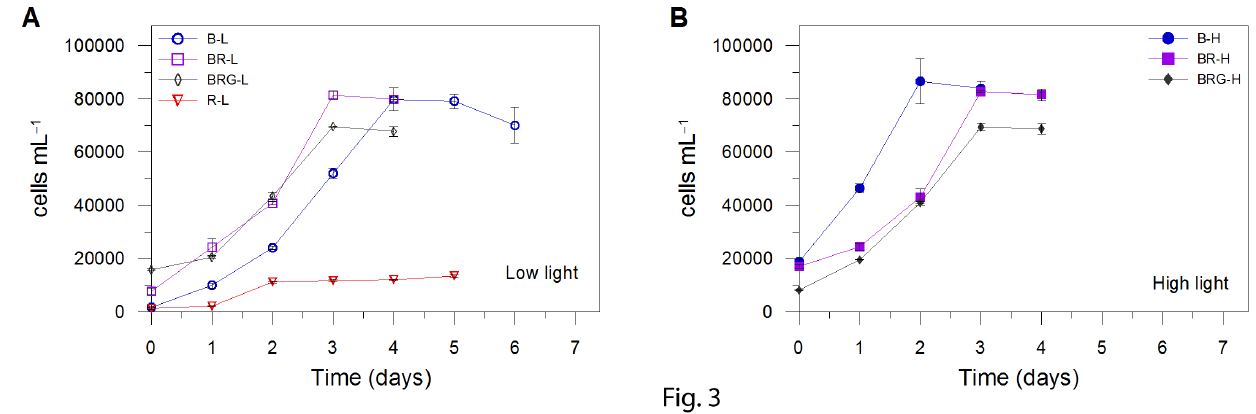
Figure 3. Growth curve of Pseudo-nitzschiamultistriata . Growth under (A) low and (B) high light. B-L, BR-L, BRG-L, R-L are blue, blue-red, blue- red-green, and red low light conditions, respectively; B-H, BR-H, and BRG-H are blue, blue-red, blue-red-green high light conditions, respectively. Red high light prevented cell growth. Experiments were performed during the exponential phase on days 3 to 5 (B-L), 1 to 3 (R-L, BR-L, BRG-L, B-H) and 2 to 4 (BR-H, BRG-H). Data represent mean 6 SD ( n